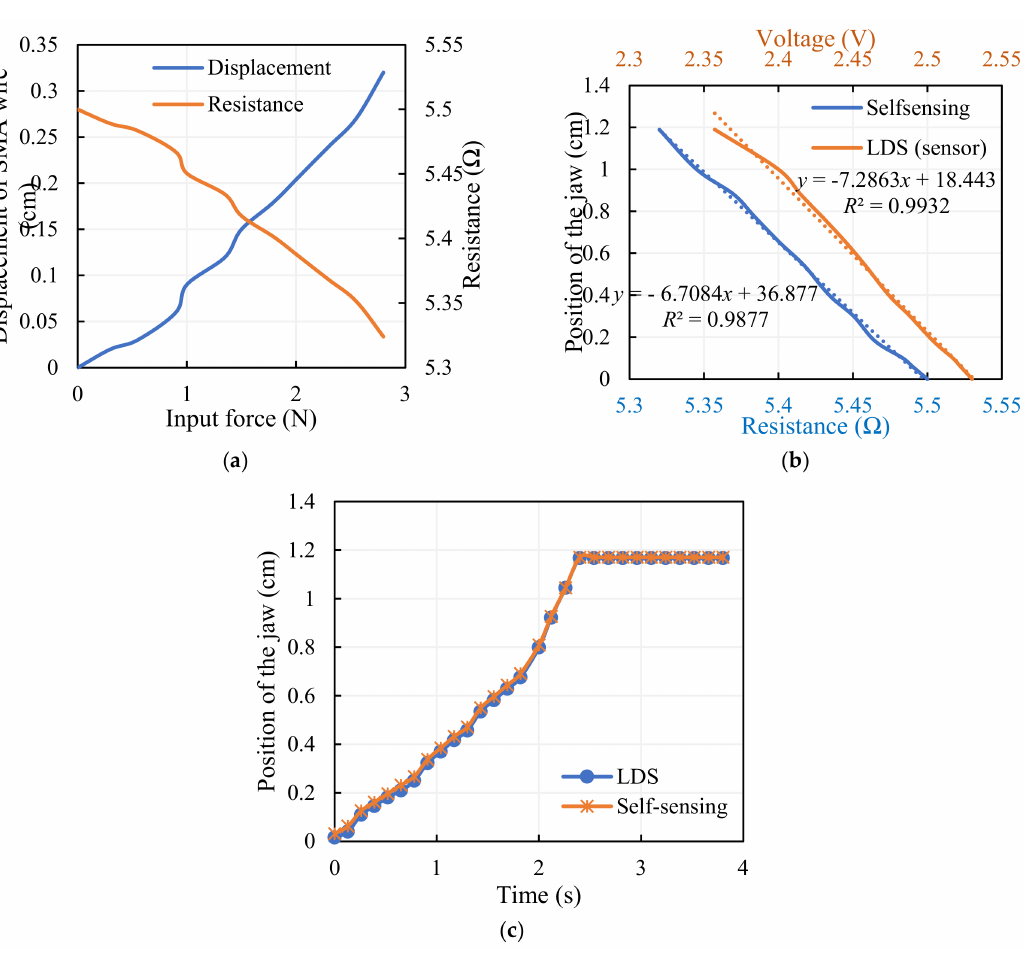
Figure 9. SMA wire as a self-sensor: ( a ) change in the characteristics of SMA wire with varying force, ( b ) performance of sensor (LDS) and self-sensor, ( c ) validation of self-sensing with LDS. A standard laser displacement sensor (LDS) is used to validate the self-sensing